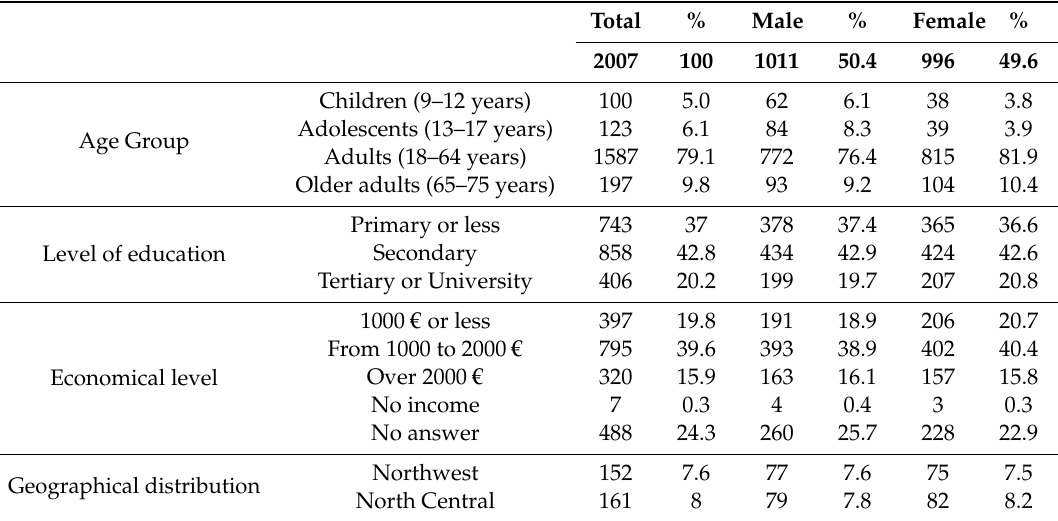
Table1. Statisticaldescriptionofthe(ANIBES)“anthropometricdata, macronutrientsandmicronutrients intake, practice of physical activity, socioeconomic data, and lifestyles in Spain” study population sample (Modified from Nissensohn et al.